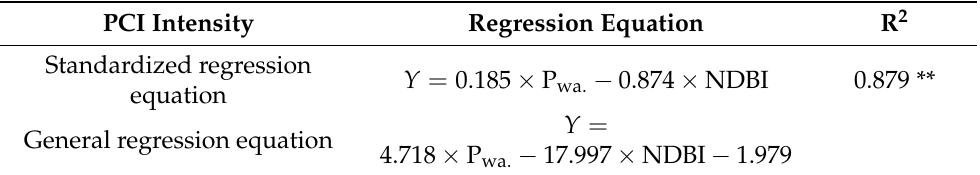
Table 4. Multiple stepwise regression models between PCI and park structure characteristics at the significance level of 0.01 ( n